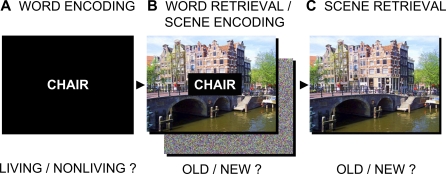
Word Retrieval/Scene Encoding TaskThe experimental task involved three phases: word encoding, word retrieval/scene encoding, and scene retrieval.(A) During word encoding, participants studied words while making semantic (living/nonliving) decisions about the study items.(B) During word retrieval/scene encoding, participants performed an old/new word recognition task including words presented at word encoding as well as words that were not seen at study. Simultaneously, spatial scenes were presented in the background(C) During scene retrieval, encoding of these spatial scenes was tested during a picture recognition task.